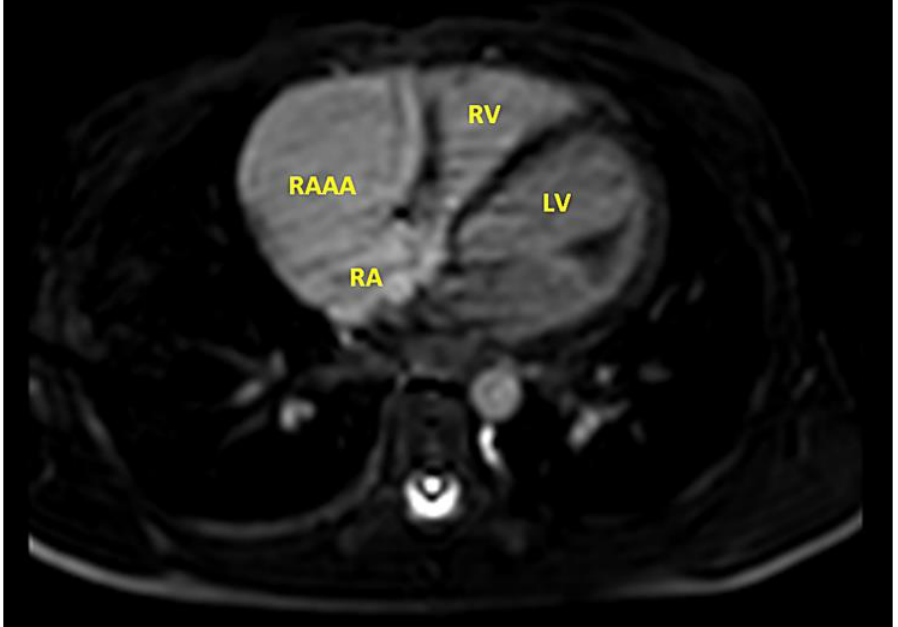
Figure 9. MRI in the same child eight years later. The initial gigantic aneurismal dilatation of the RAAA was evaluated again.